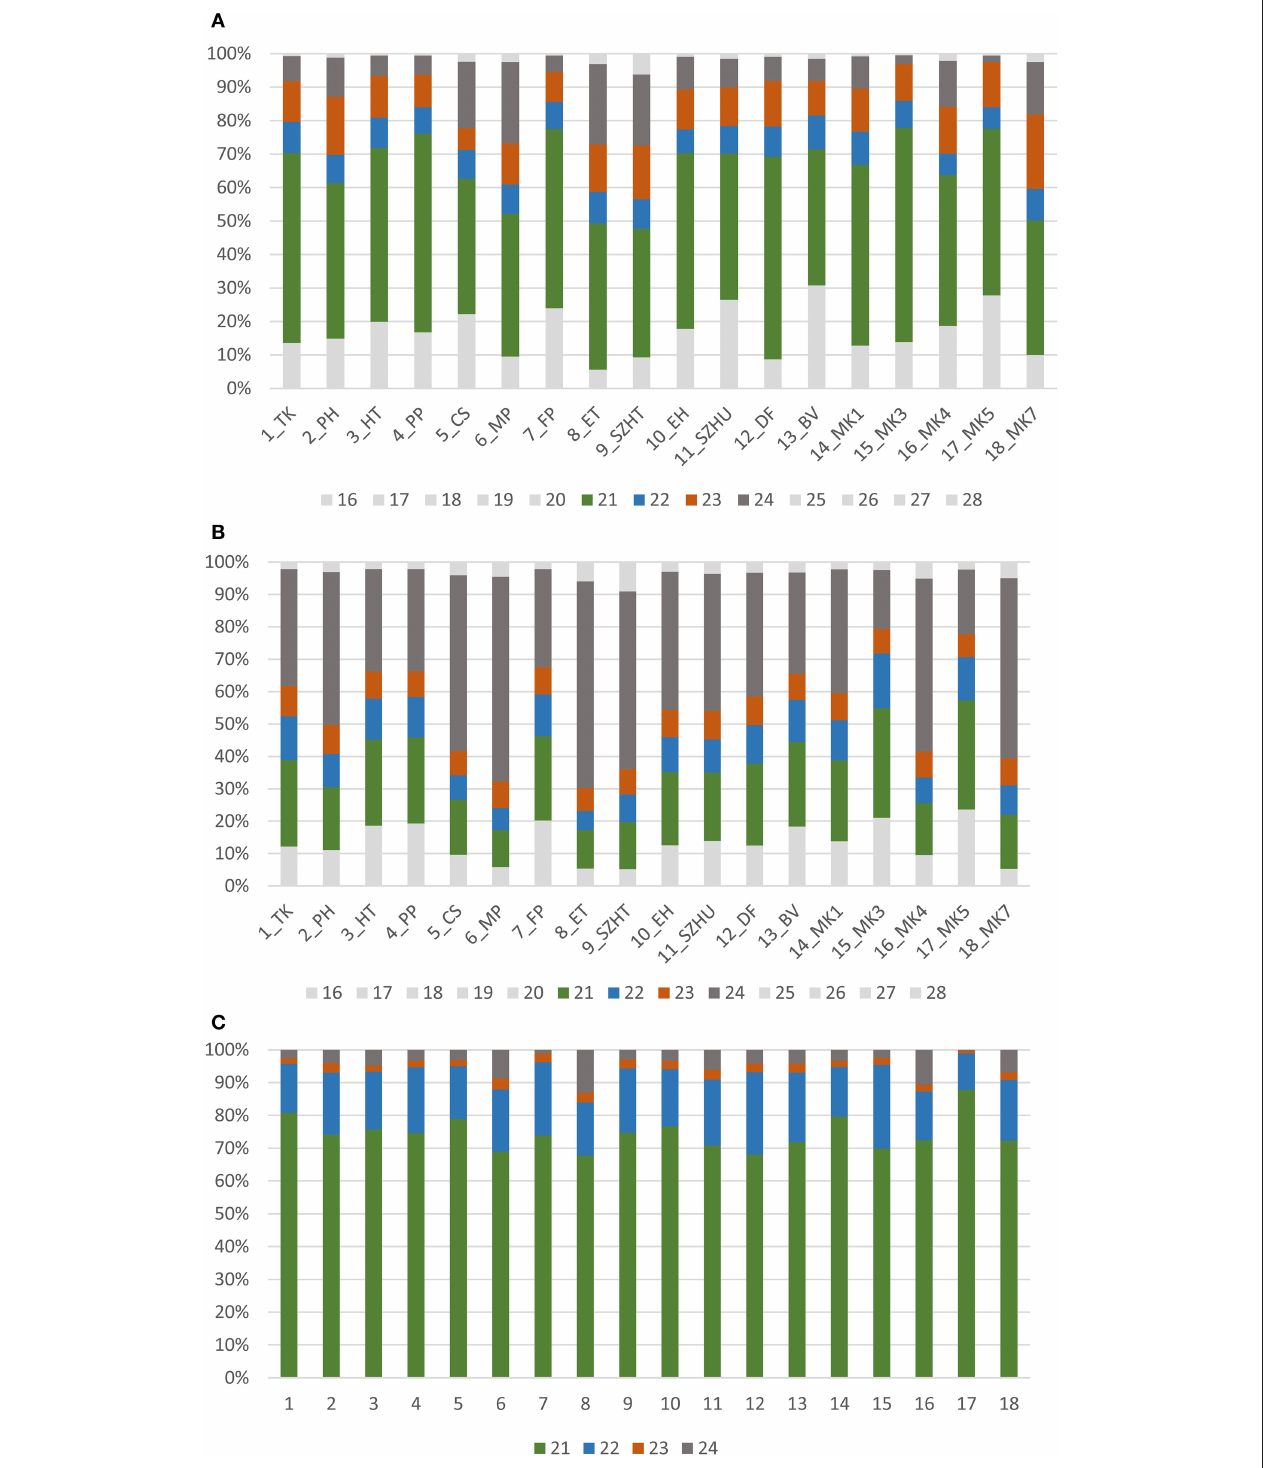
FIGURE 1 | Size distribution of (A) trimmed, (B) non-redundant, (C) viral, redundant sequenced reads of the sequenced libraries.